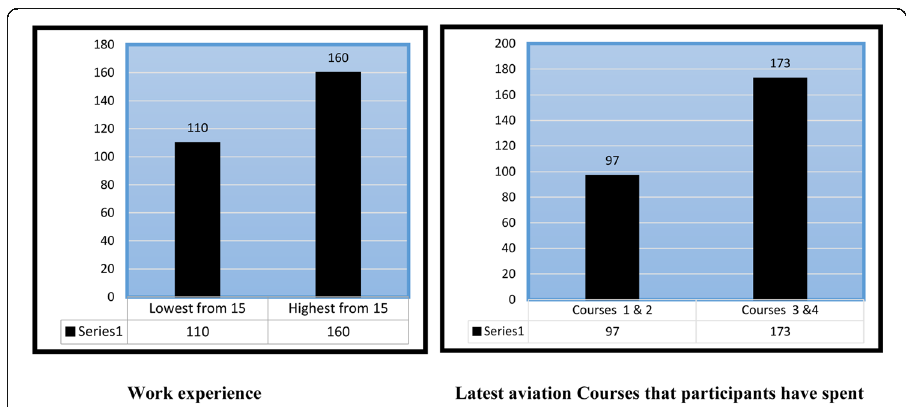
Fig. 1 Bar graphs of respondents based on their work experience, and their latest aviation Courses that participants have